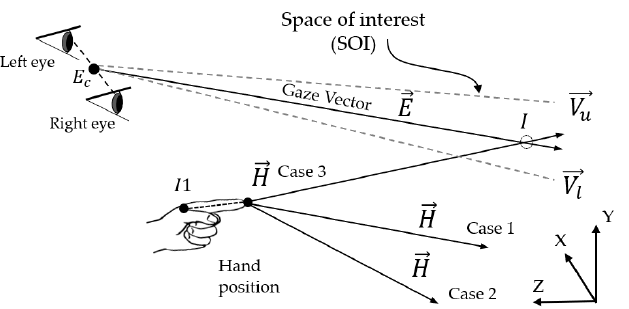
Figure 20. Crossing point determination using closest point